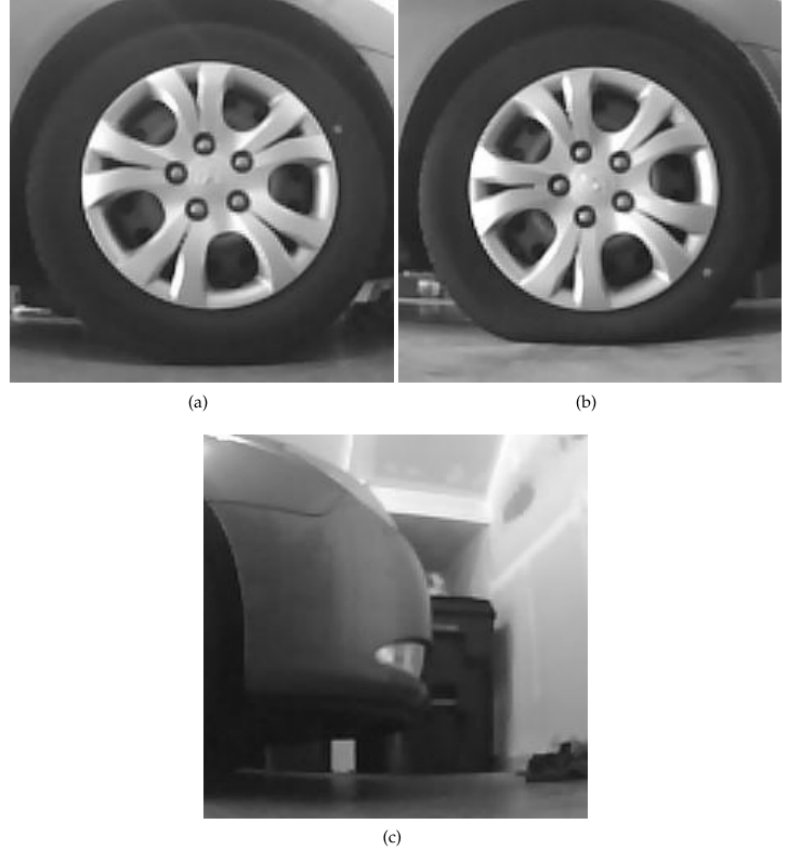
Figure 4. Different types of tires for air tire pressure fault detection. ( a ) Full tire; ( b ) flat tire; ( c ) no